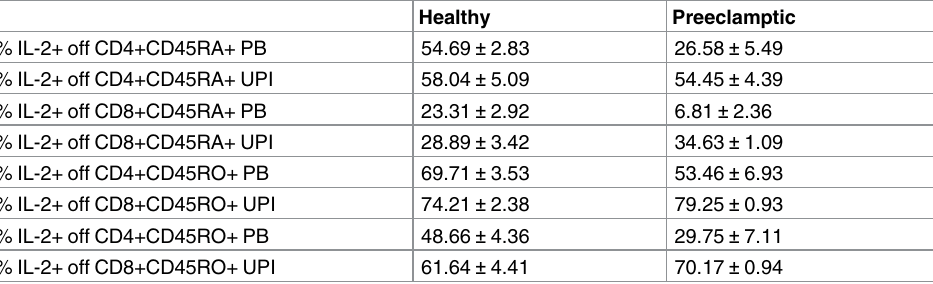
Table 6. Mean percentage +/- SEM IL-2+ CD4 or CD8+ T cells gated off total CD4+ or CD8+ T cells in PB and at the UPI of healthy and preeclamptic (PE) patients, see also Fig 1C & 1E.